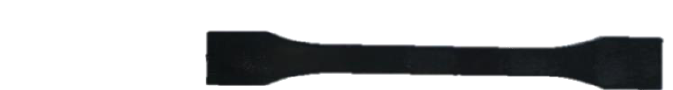
Figure 10. Shore hardness of polyethylene before and after being recycled . The average shore hardness of the original polyethylene was 47.54, being 46.9 for the recycled polyethylene; in terms of shore hardness D, these values indicate that this poly- mer can be considered hard. In view of the results, it can be concluded that the hardness of the material was not affected by recycling. On the other hand, although the hardness in polymers cannot be directly related to tensile strength (as it is in steels), it gives us an idea that the strength of recycled polyethylene must be similar to that of the original, as shown in previous sections. 3.2. Characterisation of Recycled Polyethylene Fibres 3.2.1. Geometric Properties of Recycled Fibres For the analysis of the geometrical properties of the fibres, firstly, the diameter of 100 fibres was measured, obtaining an average value of 1.730 mm with a standard deviation of 0.365 mm. Therefore, it can be seen that the thickness of these fibres is considerably greater than the fibres usually used.